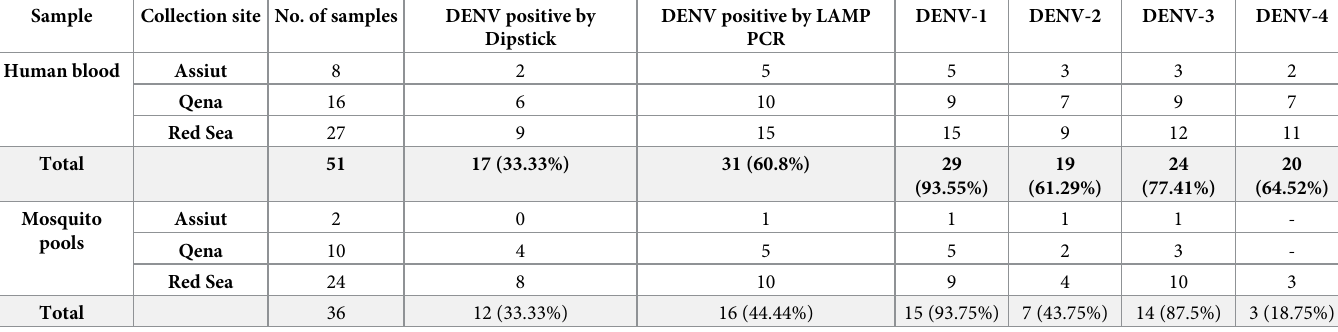
Note: The number of DENV serotypes reported in the table represents single infections and mixed